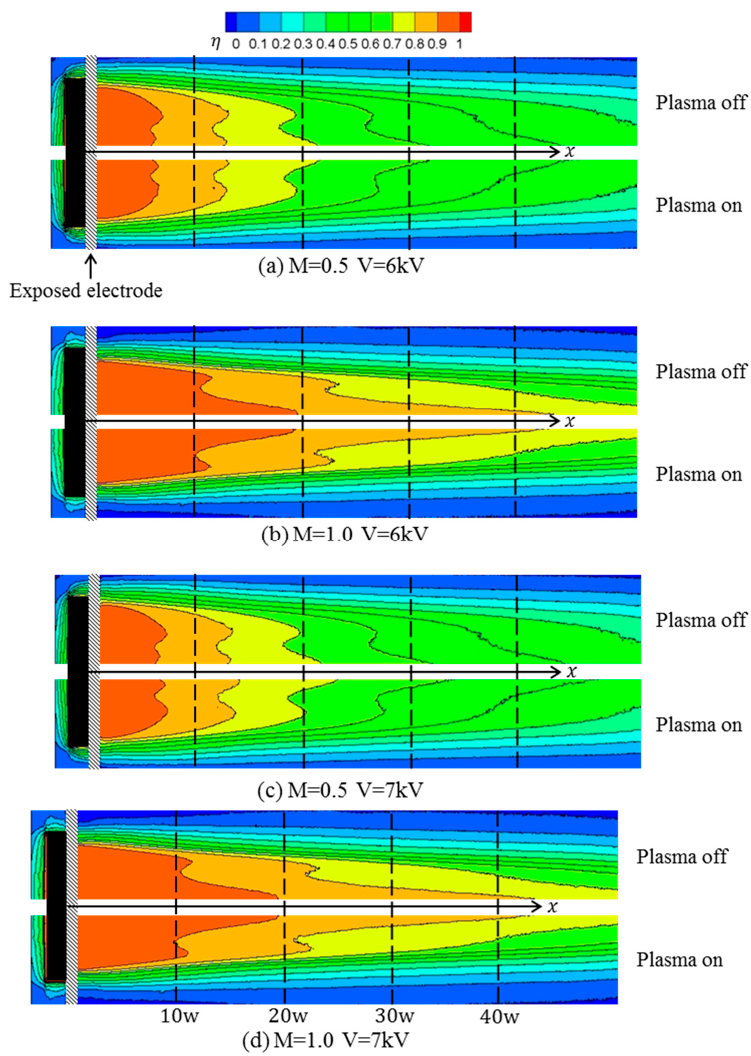
Figure 5. Distributions of film cooling effectiveness ( L e = 0 w).